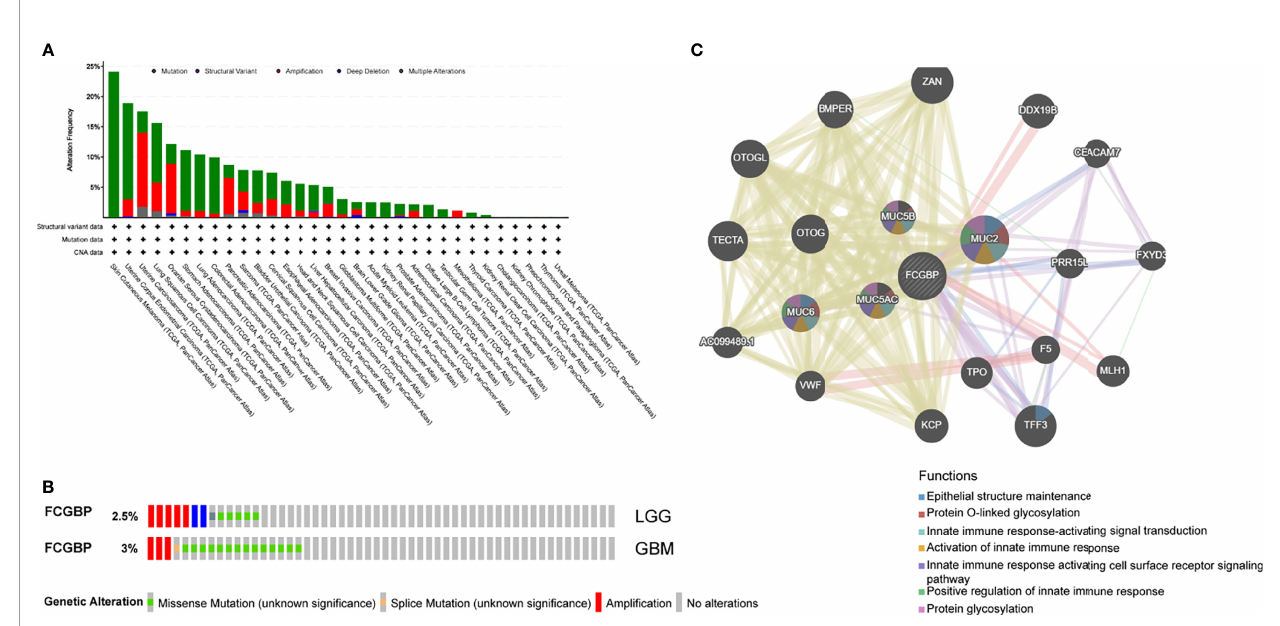
FIGURE 4 | Analysis of genetic changes in glioma, and interacting gene network of FCGBP. (A) Genetic alterations of the FCGBP gene were analyzed by cBioPortal. (B) The mutation frequency of FCGBP in LGG and GBM. (C) FCGBP ’ s interactive network was generated through the GeneMANIA database.